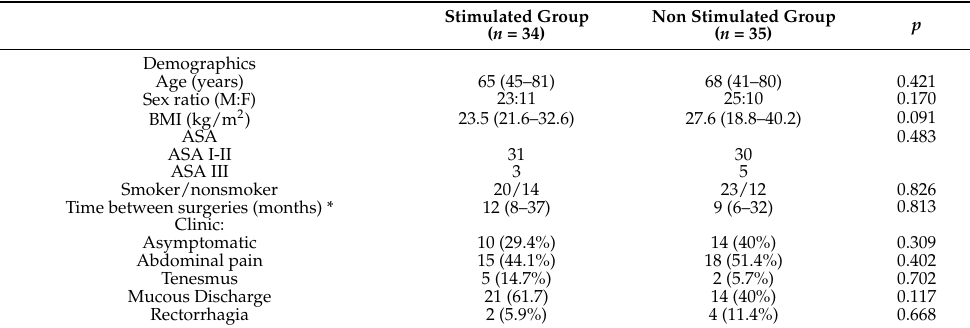
Table 1. Demographics and clinics characteristics in Stimulated and Control group.